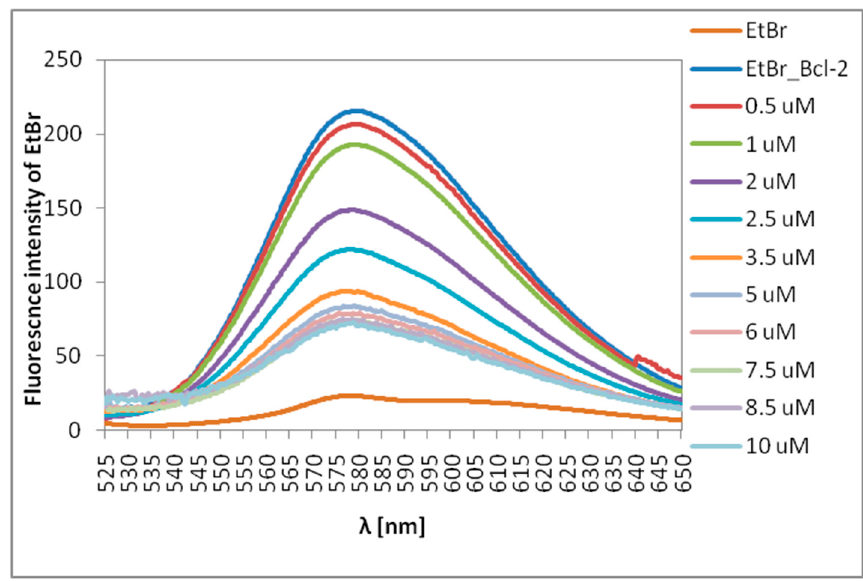
Figure 4. Dependence of the fluorescence intensity of the EtBr-Bcl-2 complex on an increasing concentration of CBD-2.